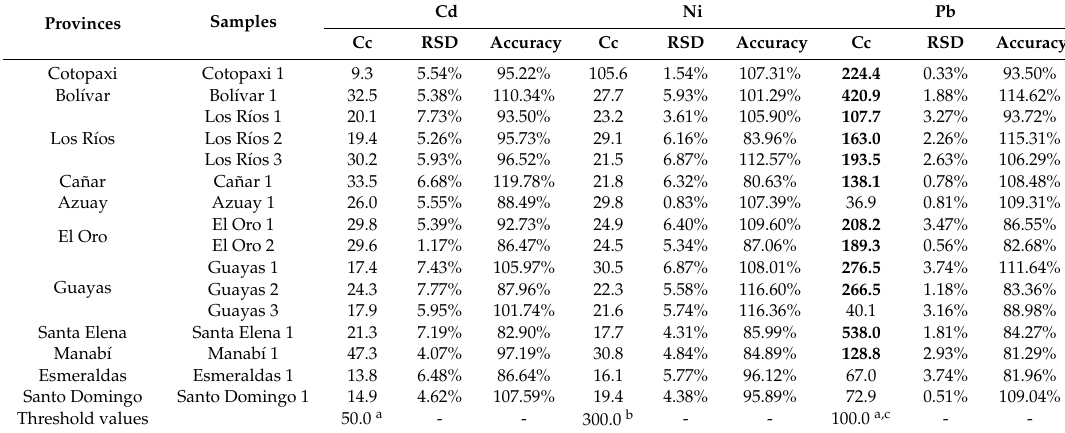
Table1. Resultssummaryofconcentrationsinoriginalsamples(Cc, µ g · kg − 1 ), ratesofstandarddeviation (RSD, %), and “in-house” accuracy (%) of cadmium (Cd), nickel (Ni), and lead (Pb) determinations in Ecuadorian banana samples and the threshold values ( µ g · kg − 1